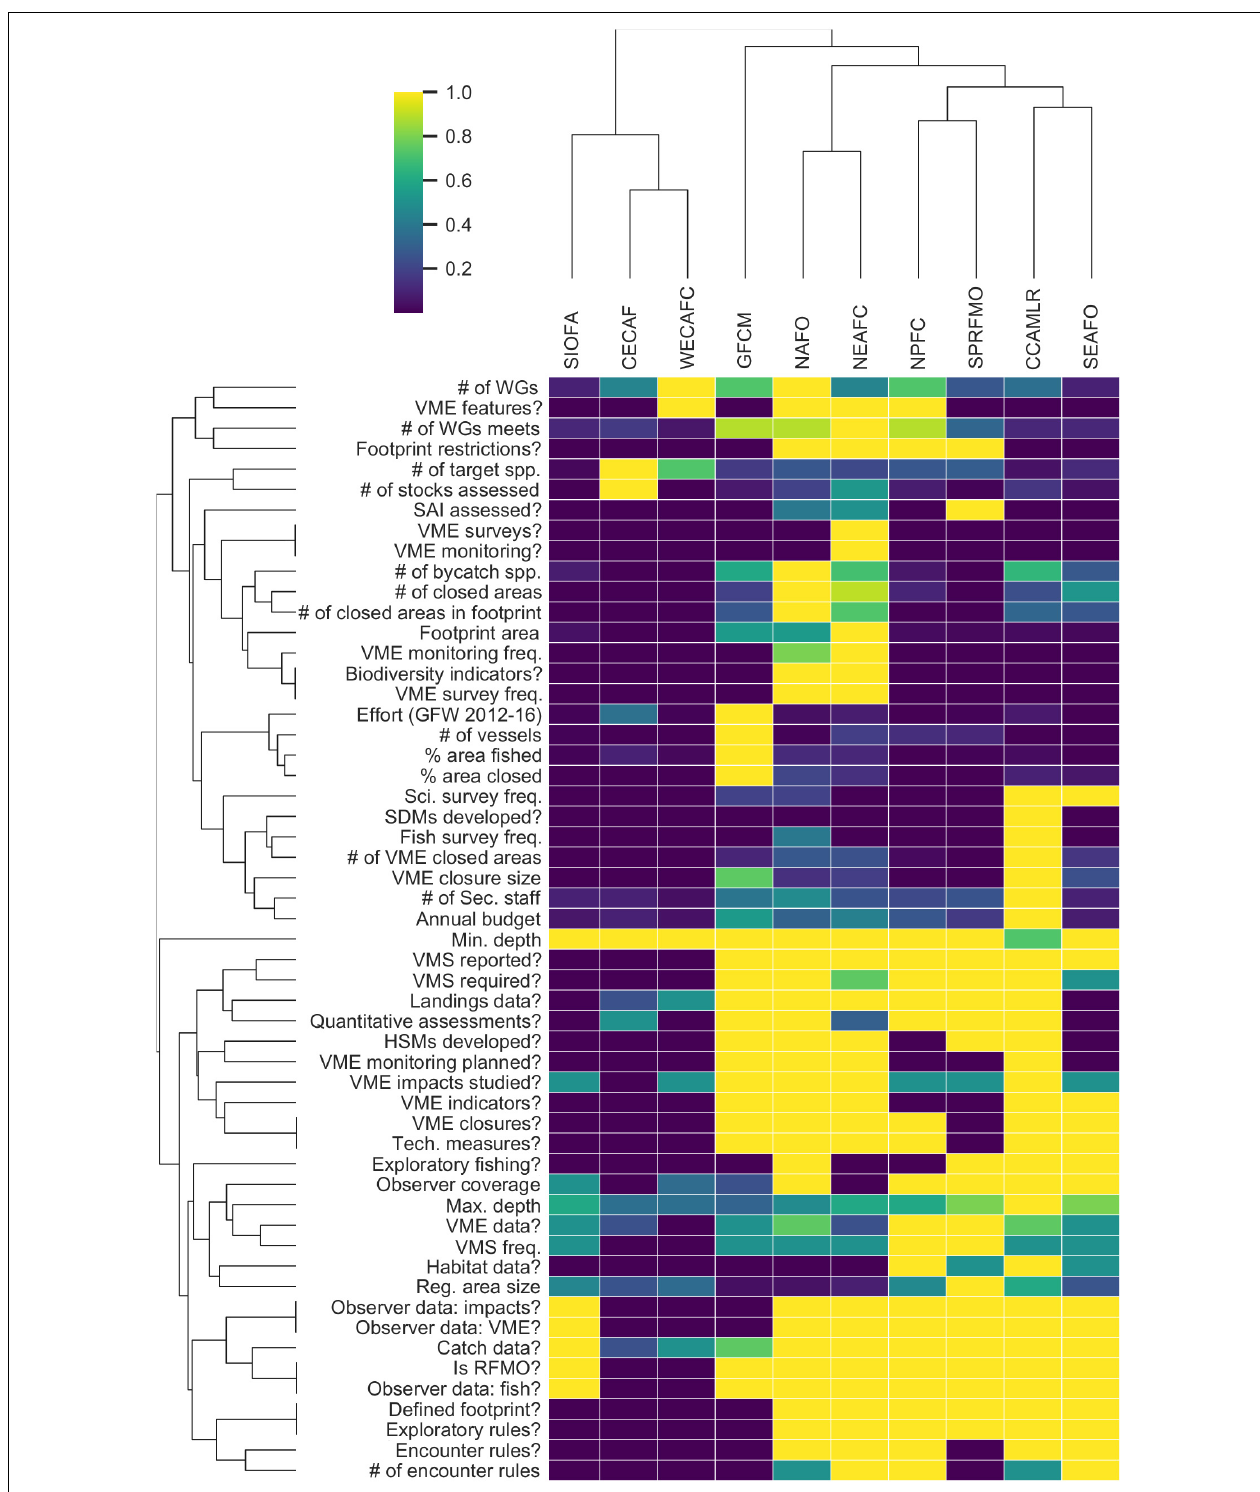
FIGURE 5 | Interactions between RFMOs and different category scores. Average linkage cluster dendrograms (based on Euclidean distance dissimilarity matrix) used to order the plot axes, with color indicating the score value. spp., species; HSM, habitat suitability model; SDM, species distribution model; VMS, vessel monitoring system. N.B. Criteria with too few scores, or where all organizations scored zero, are not included. See Supplementary Appendix S3 for PCA ordination. CCAMLR – Convention for the Conservation of Antarctic Marine Living Resources; CECAF – Fisheries Committee for the Eastern Central